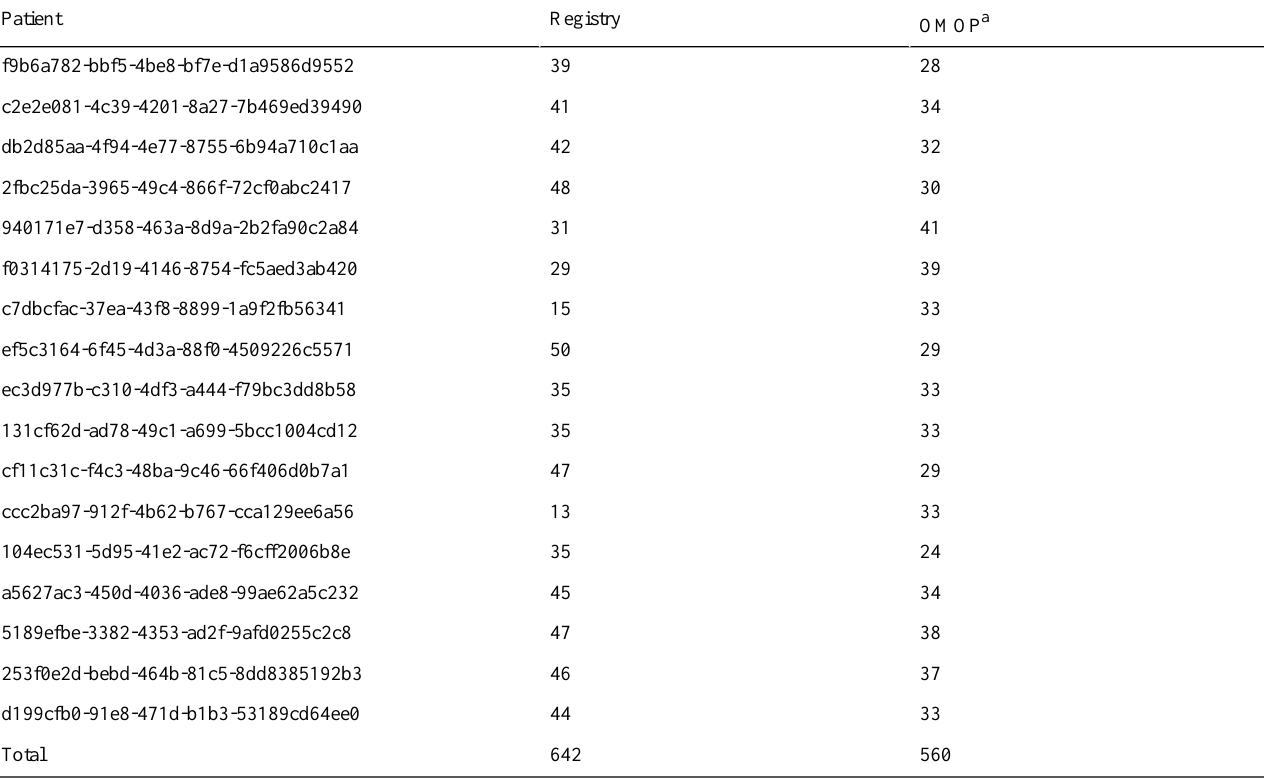
Table 4. Overall patient scores for registry vs Observational Medical Outcomes Partnership